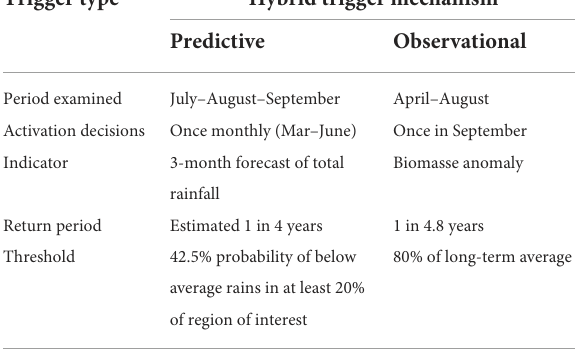
TABLE 2 Example of a hybrid (predictive and observational components) anticipatory action trigger mechanism for drought in